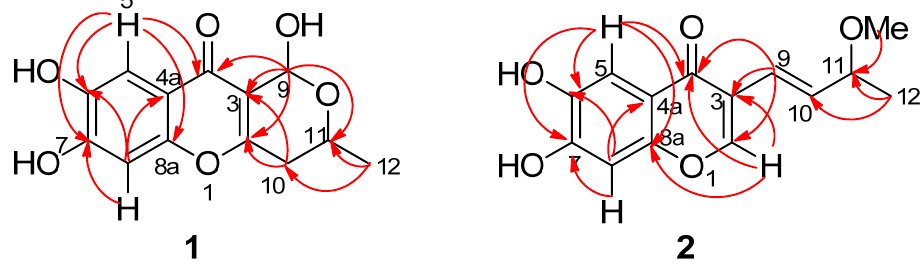
Figure 2. Key HMBC correlations of compound 1 and 2